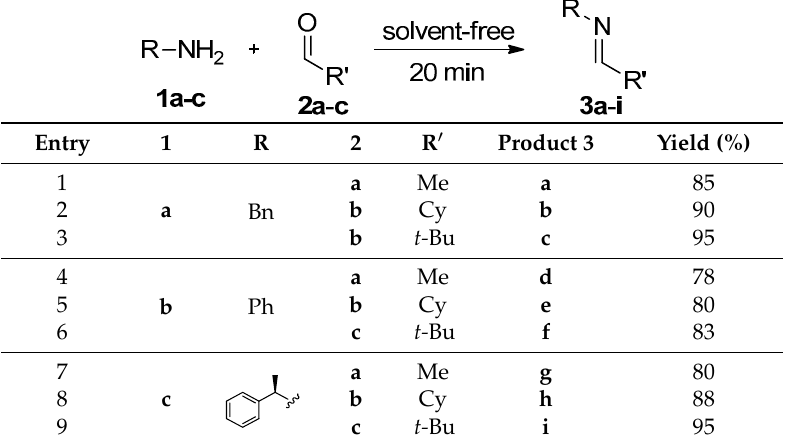
Table 1. Solvent-free synthesis of C -alkyl substituted N -protected aldimines.